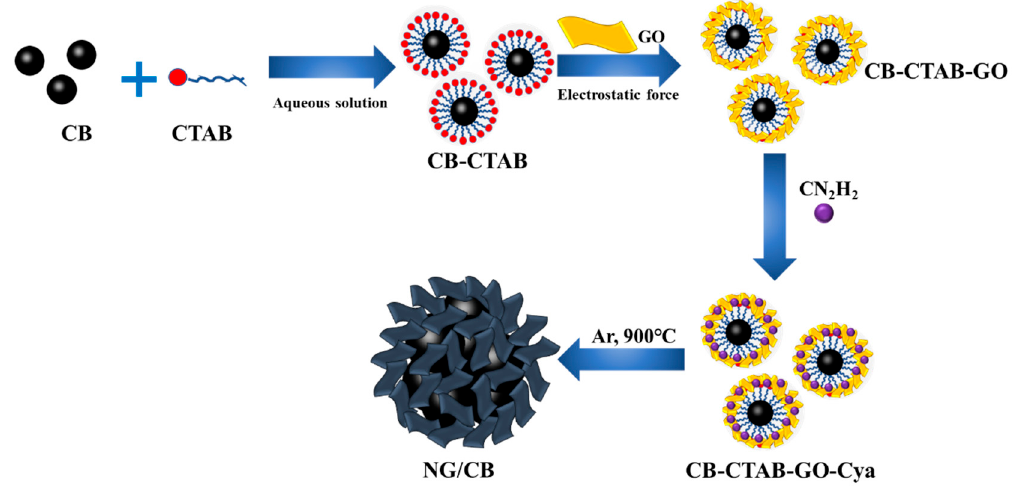
Figure 1. Schematic route of synthesis of nitrogen-doped graphene / carbon black -x electrocatalysts.